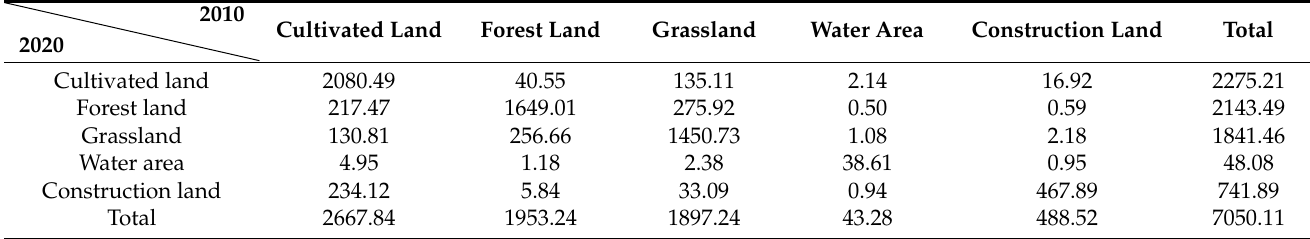
Table 11. The land use transfer matrix in Taiyuan from 2010 to 2020 (unit: km 2